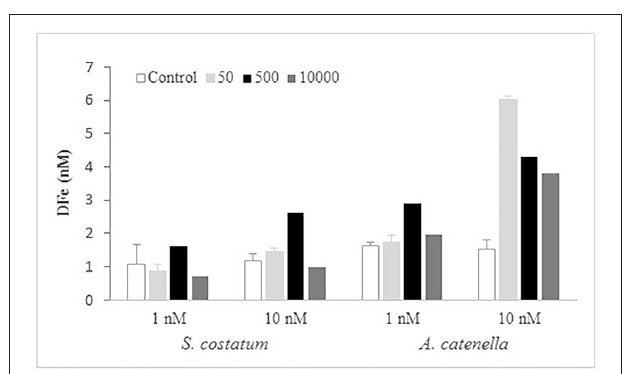
FIGURE 5 | Dissolved labile iron (DFe) concentration (nM) measured at the final day for four of the desferrioxamine B (DFB) treatments (Control, 10, 100, 10,000nM) in each culture with S. costatum and A. catenella